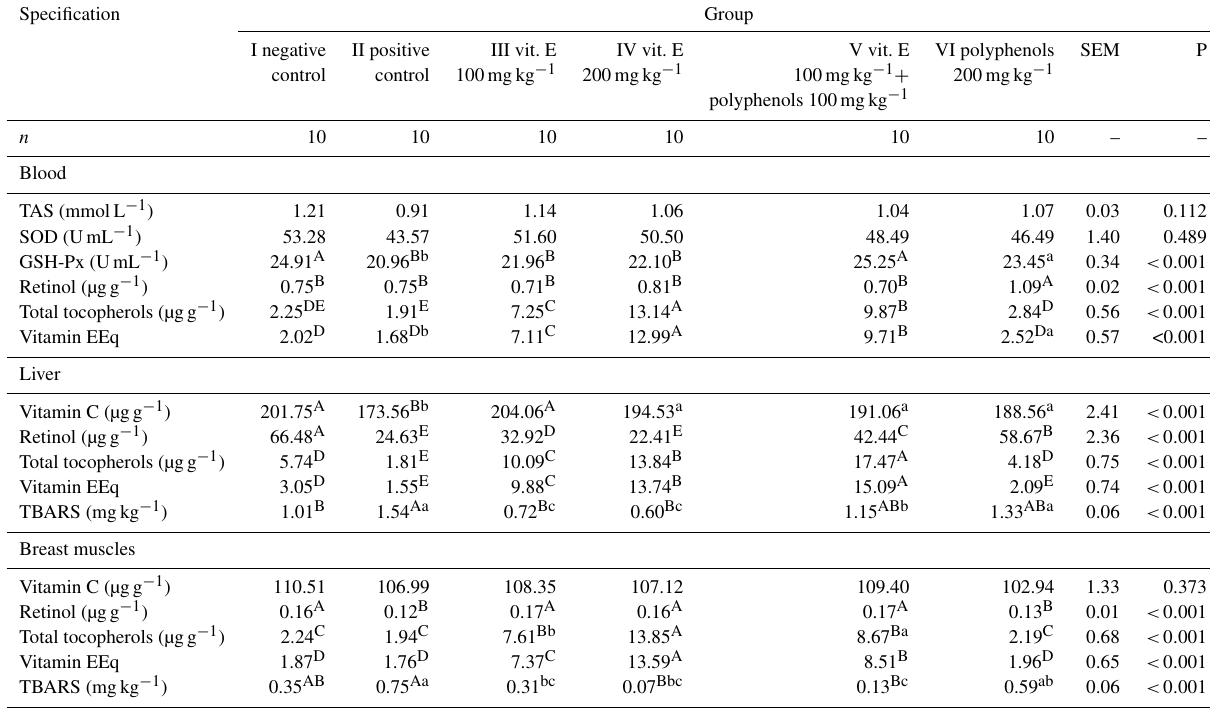
Table 4. Antioxidant status of broiler chickens fed low-quality oil.